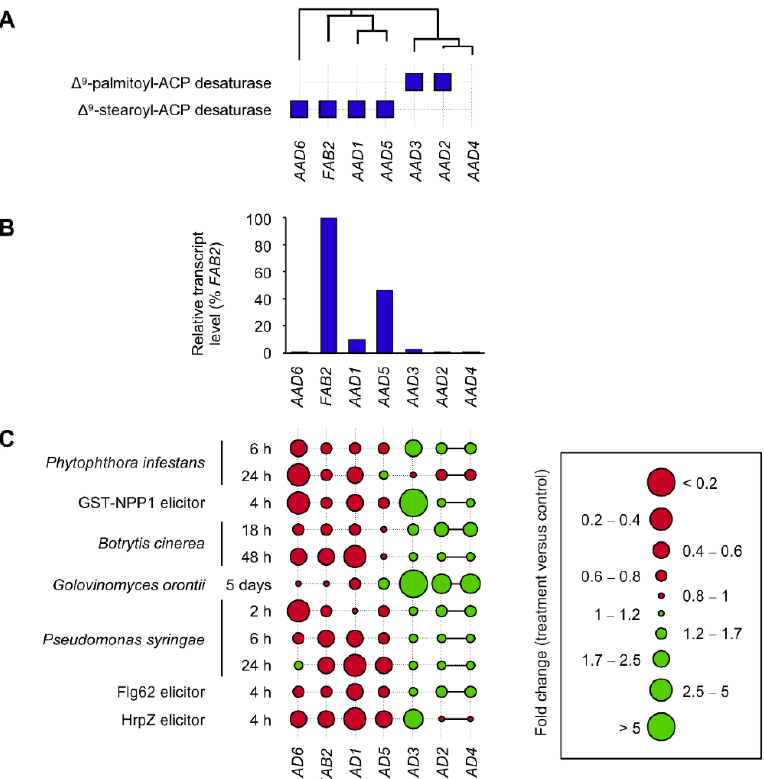
Figure 1. Transcriptional regulation of AAD genes in the leaves of Arabidopsis thaliana in response to biotic stress. ( A ) Phylogram, with branch lengths in arbitrary units, using the alignment of the seven A. thaliana AAD sequences (with gaps). Enzymatic activities of the AAD isoforms are indicated below the phylogram (blue squares). The activity of AAD4 remains unknown. ( B ) Relative AAD transcript levels in control leaves of A. thaliana expressed as a percentage of FAB2 transcript